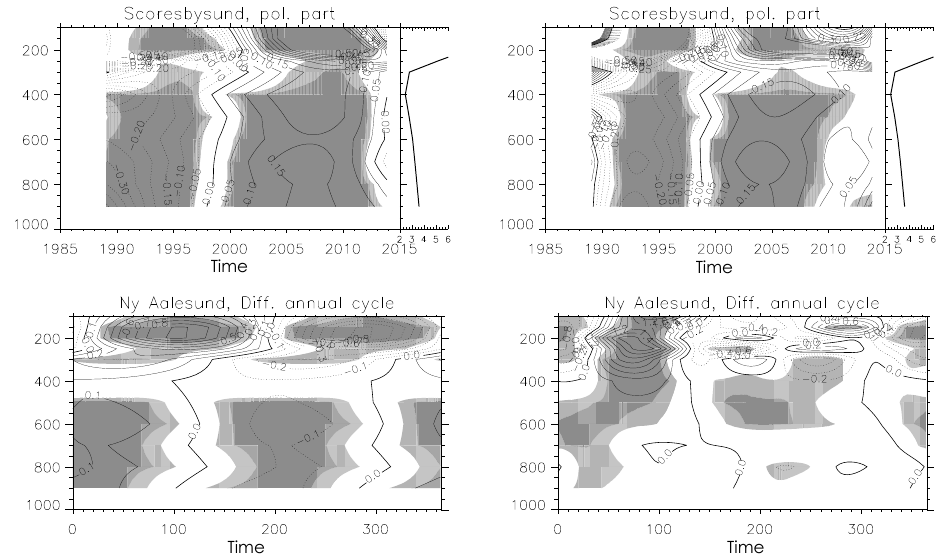
Figure 12. Top: the polynomial part of the model as a function of time and pressure for Scoresbysund. The models are (left) n pol = 4, n cyc = 3, and n a tr = n θ tr = 2, and white noise; (right) n pol = 5, n cyc = 3, and n a tr = n θ tr = 3, and AR1 noise. Compare also to the top right plot in Fig. 7, which does not include trends in annual cycle ( n pol = 4, n cyc = 2, n 1 tr = n θ tr = 0 and white noise). Bottom: difference between average annual cycles over 1995–2000 and 2007–2012 as a function of pressure level for Ny Ålesund. Left: n pol = 4, n cyc = 1, n a tr = n θ tr = 1, and AR1 noise. Right: n pol = 5, n cyc = 3, n a tr = n θ tr = 3, and AR1 noise. Compare also to the lower left panel in Fig.